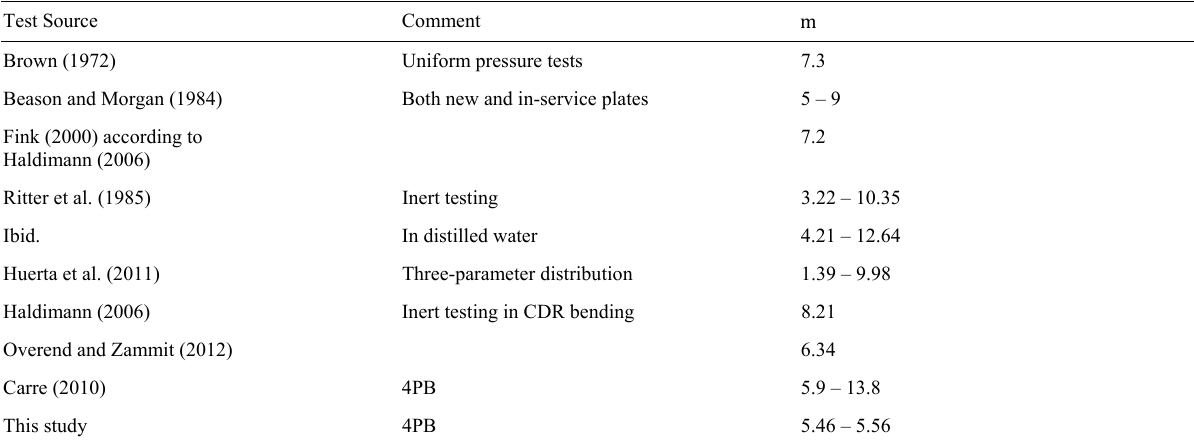
Table 4: Reported estimates of the Weibull modulus